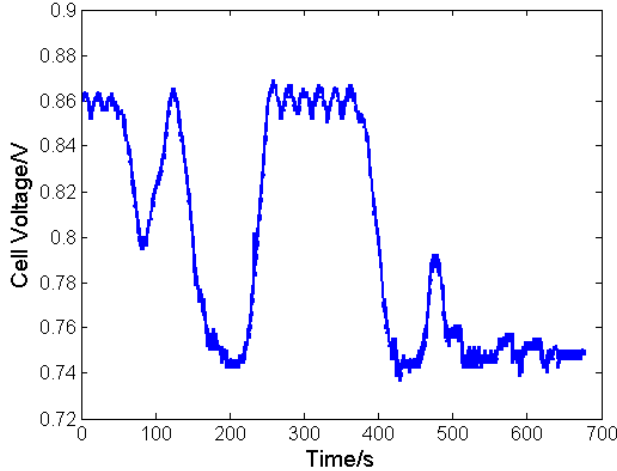
Figure 14. Cell voltage trend.